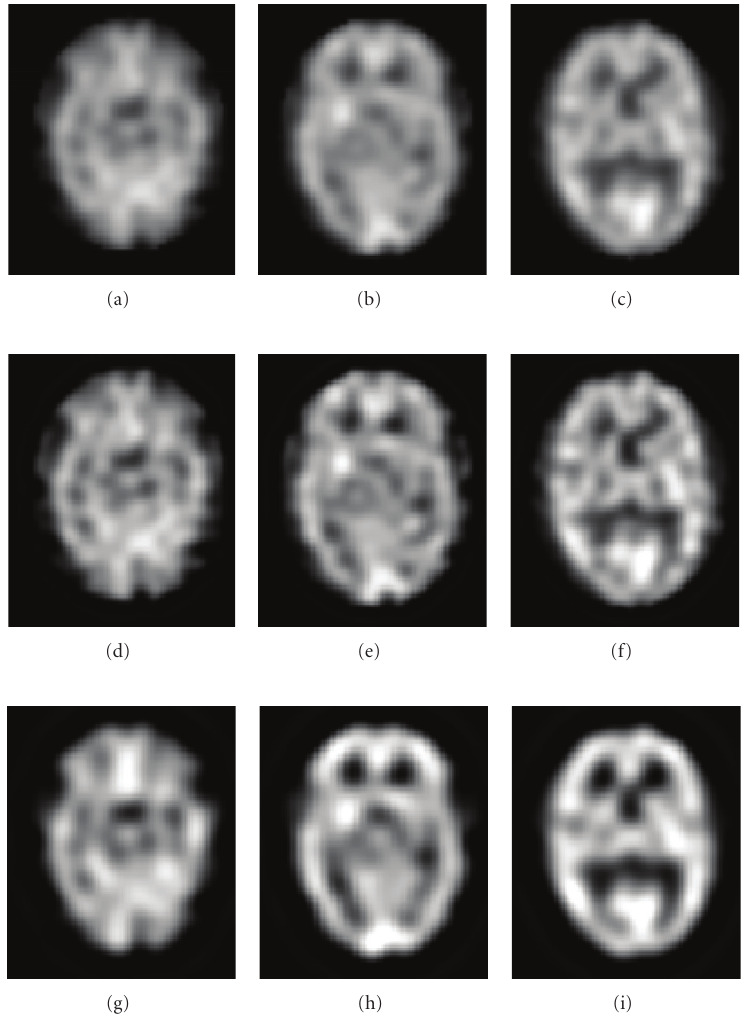
Figure 9: Restoration results. Axial view of: (a), (b) and (c): Original SPECT cross-sectional images. (d), (e) and (f): deconvolution result with Metz filter. (g), (h) and (i): deconvolution result with our